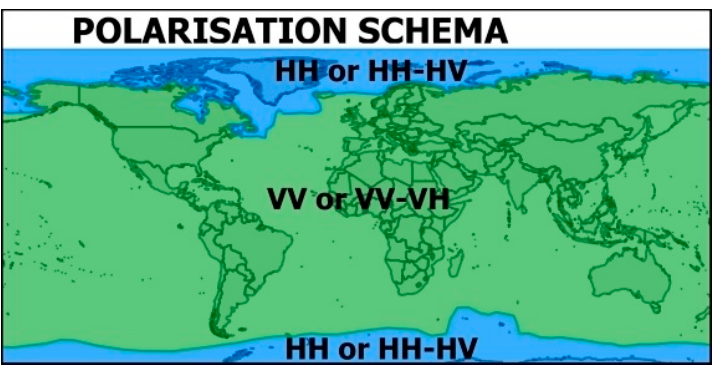
Figure 11. Sentinel-1 acquisition polarisation schema. (Source: European Space Agency “Sentinel High Level Operations Plan (HLOP)”).